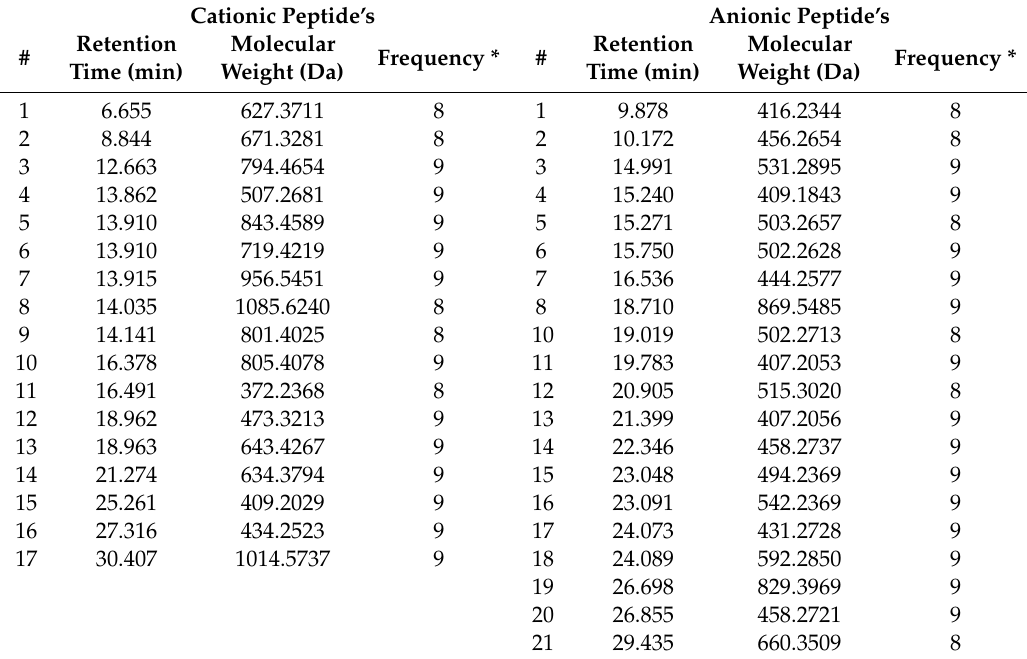
Table 2. Cationic and anionic peptides simultaneously present in each cationic (C FFC , C RC1 , and C RC3 ) and anionic (A RC1 , A RC2 , and A RC3 ) bioactive